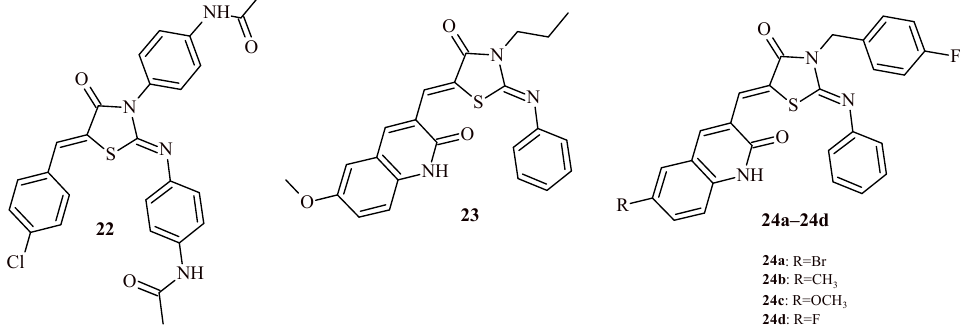
Figure 12. The structures of 2-iminothiazolidin-4-one derivatives with anti-breast cancer activity.